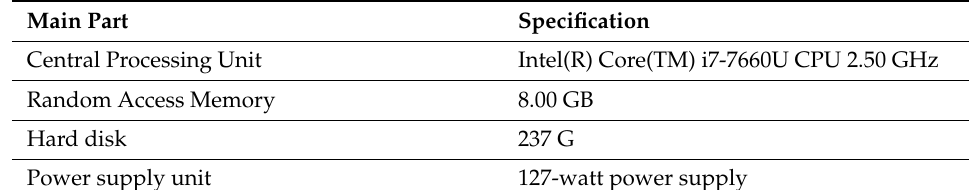
Table 1. The description of experiment environment.